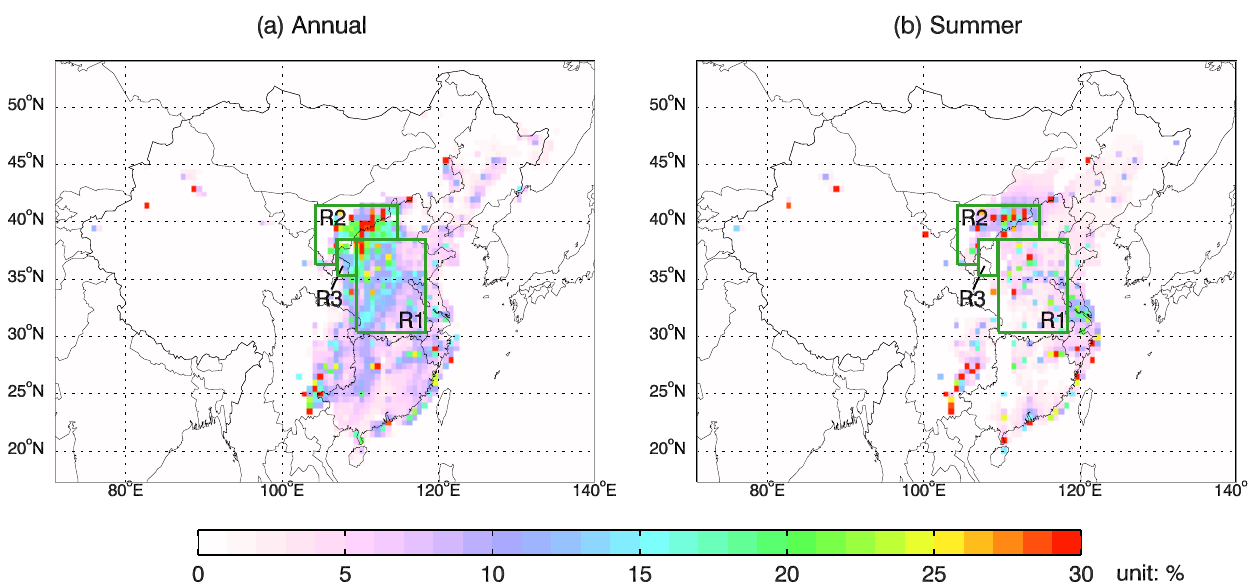
Fig. 12. Relative contributions of the new power plant NO x emissions to the (a) annual average NO 2 columns and (b) summer average NO 2 columns in 2007, defined as Eq. (2). Only grids inside Chinese boundary and with average NO 2 columns > 1.0 × 10 15 moleculescm − 2 in GC PP are colored. Domains of three studied regions are indicated in green rectangles. Fig. 13 1